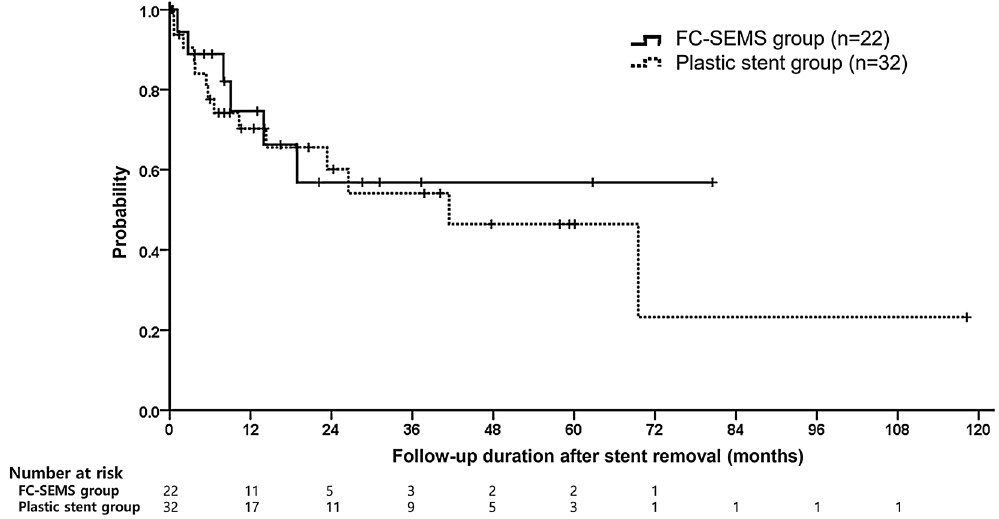
Figure 3. Kaplan-Meir estimation of recurrence-free survival after stent removal in the FC-SEMS (n = 22) and plastic stent group (n = 32). There were no significant differences in recurrence-free survival between the FC-SEMS and plastic stent groups (50.1 (95% CI, 31.2—69.1) vs. 51.7 (95% CI, 28.7—74.7) months, log-rank p = 0.646). Abbreviation: FC-SEMS, fully covered self-expandable metal stent; CI, confidence